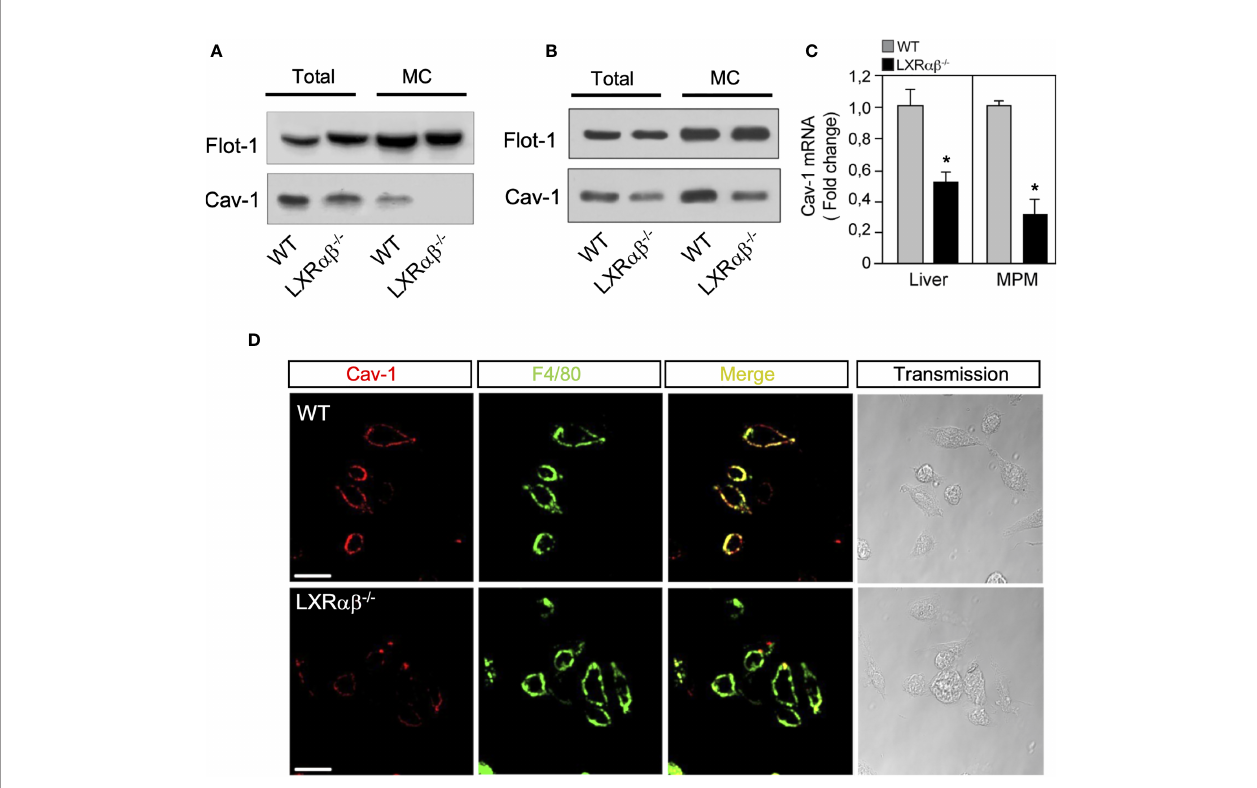
FIGURE 2 | Cav-1 expression is impaired in LXR ab -/- mice. Representative Western blot analysis of Cav-1 in whole-cell lysates (Total) and microsomal fractions (MC) of peritoneal macrophages (A) and liver (B) from in WT and LXR ab -/- mice. (C) mRNA expression of Cav-1 by real-time qRT-PCR in peritoneal macrophages and liver from WT and LXR ab -/- mice. Data are expressed as relative expression levels and correspond to the means ± SEM from three independent experiments performed in triplicate * P<0.05 (signi fi cantly different from WT [normalized to 1]). (D) Representative confocal images of Cav-1 expression (red) and F4/80 (green) in peritoneal macrophages from WT and LXR ab -/- mice. Experiment was performed 3 independent times. Scalebar: